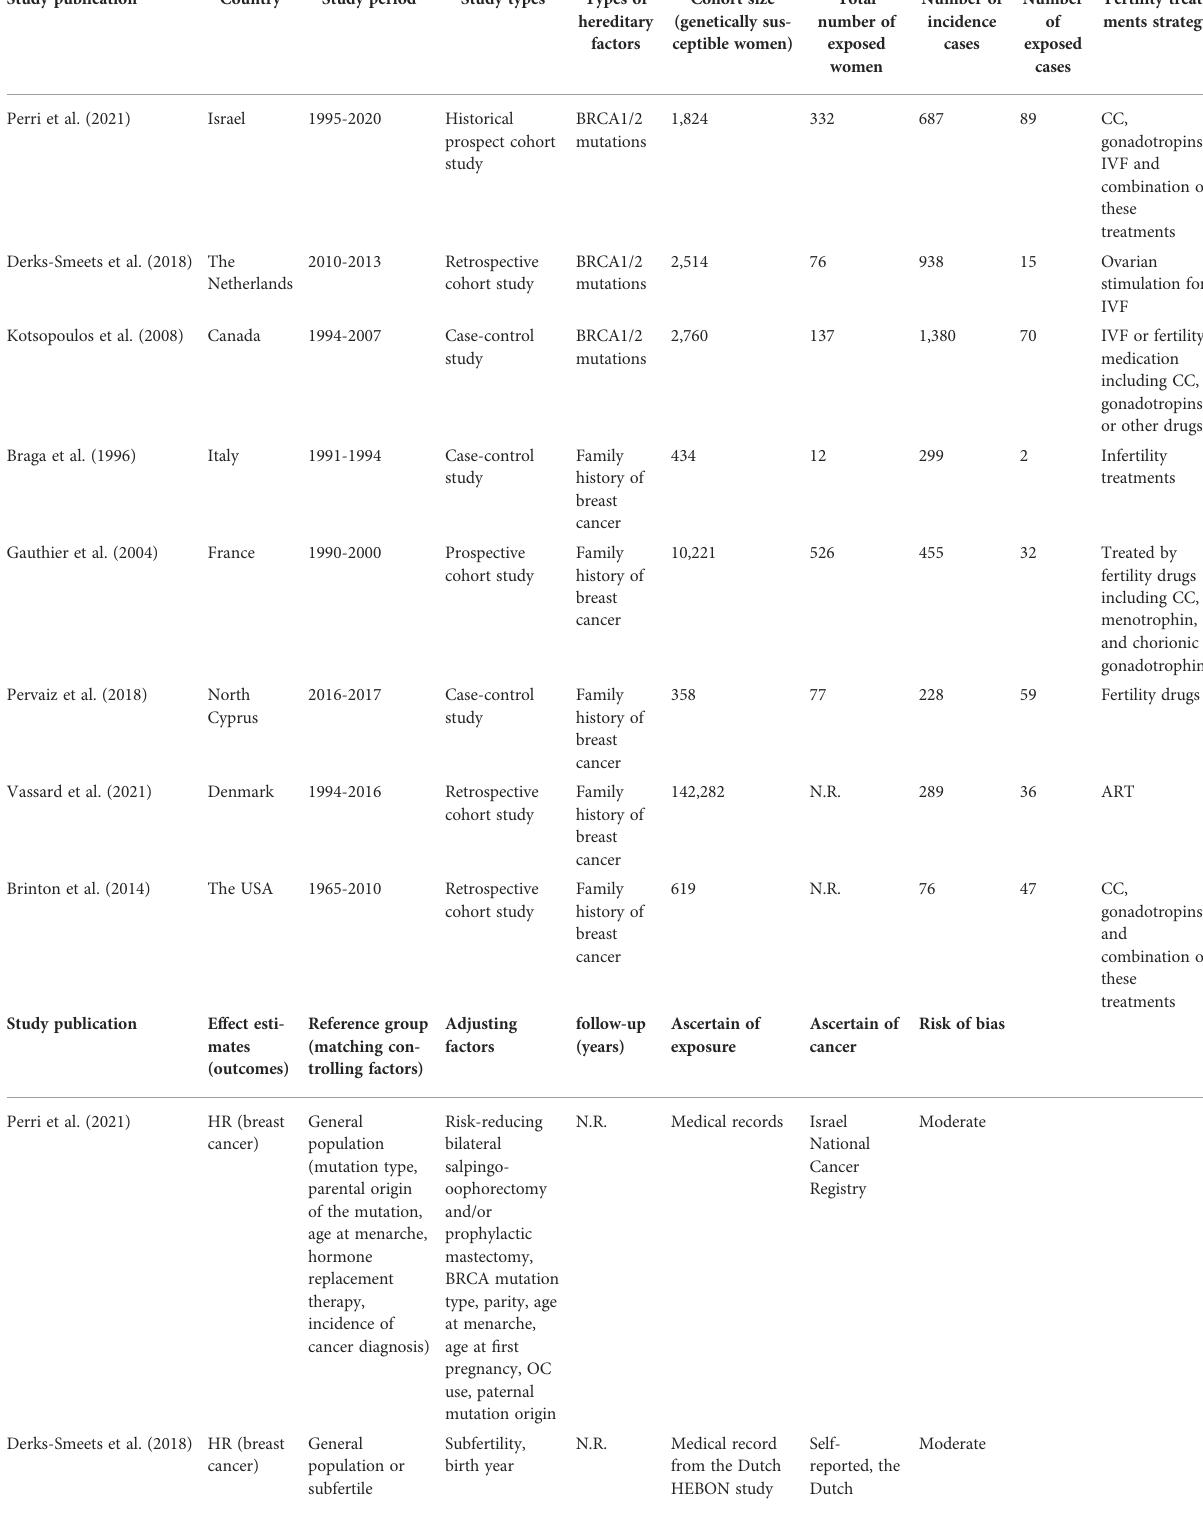
TABLE 1 Characteristics of included studies in the meta-analysis of the impact of fertility treatments on breast cancer risk in genetically susceptible